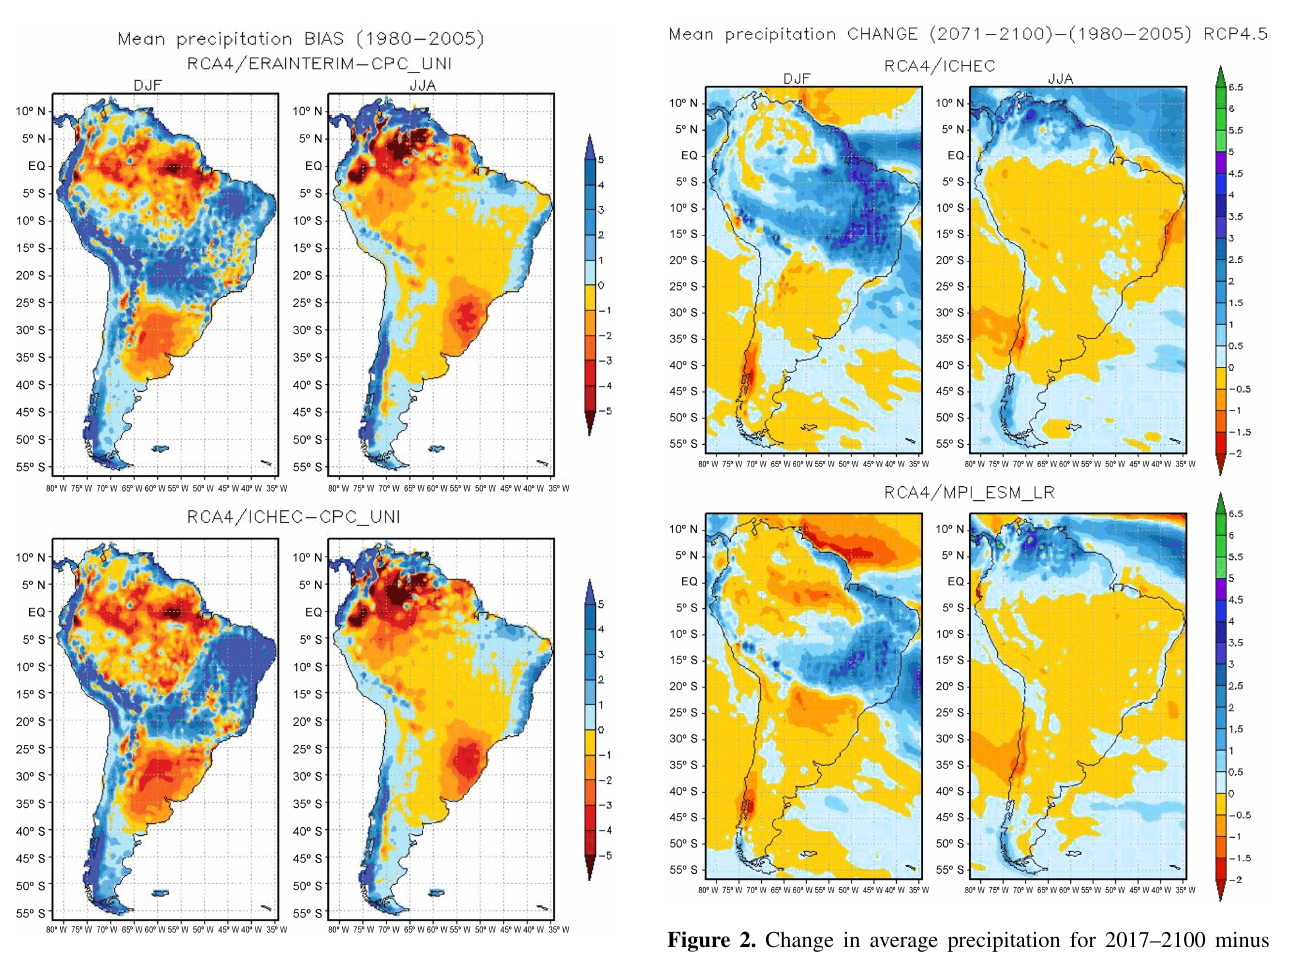
Figure 1. Bias in 1980–2005 precipitation simulations by regional model RCA4 for South America when using boundary conditions from the ERA-Interim reanalysis (top row) or the EC-Earth GCM run by the Irish Centre for High-End Computing (ICHEC; bottom row). Reference observations are from the CPC Unified Gauge- Based Analysis of Global Daily Precipitation (CPC, 2016). Biases are for the seasons December–January–February (DJF; left side) and June–July–August (JJA; right side). Units are mmd − 1 .